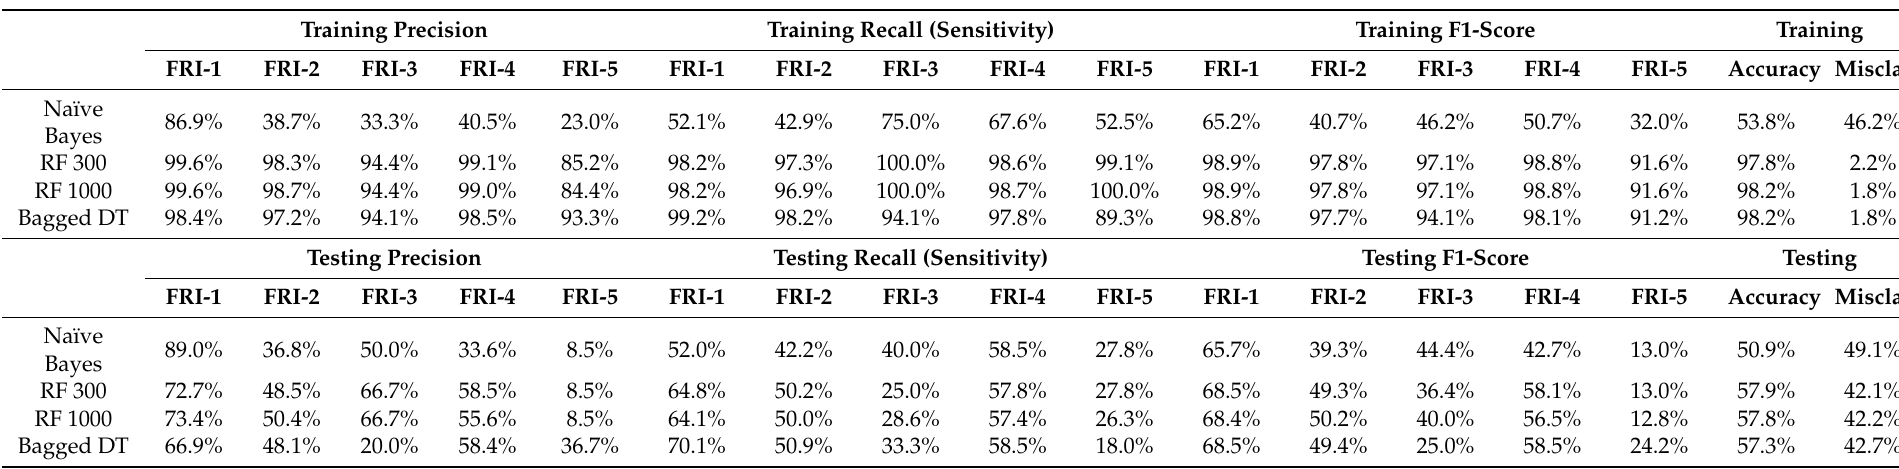
Table 2. Predictive model performance comparison for different class predictions in the different ML